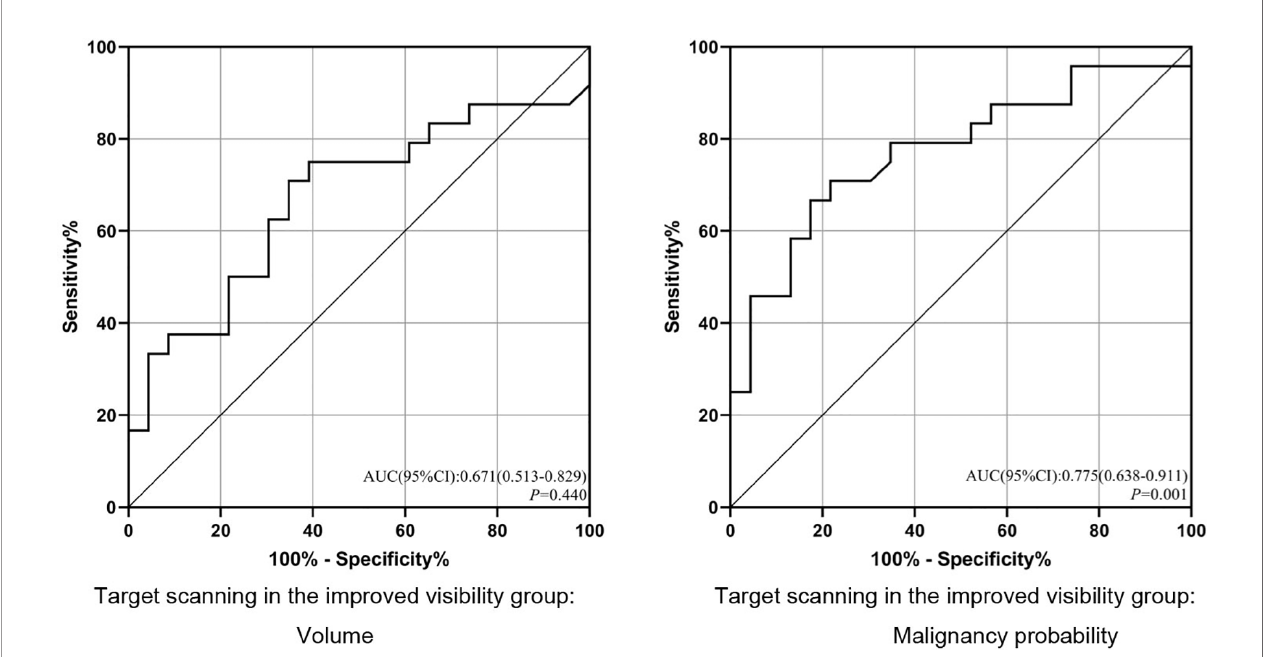
FIGURE 5 | ROC analysis of the prediction model for improved visibility. ROC, receiver operating characteristic; AUC, area under the ROC curve. p < 0.05.